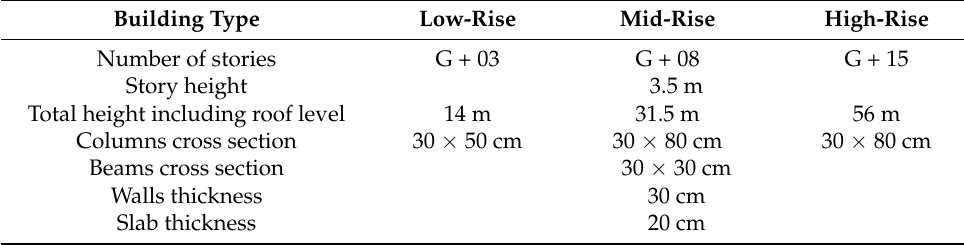
Figure 1. Plan view of the buildings (units in m). Table 1. Description of the investigated